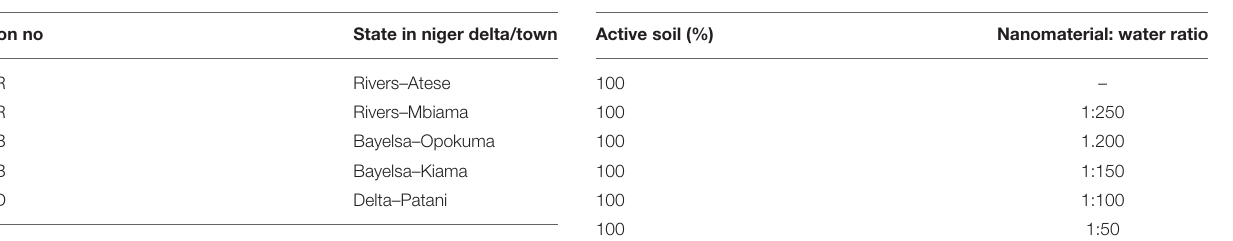
TABLE 1 | Samples location and state.